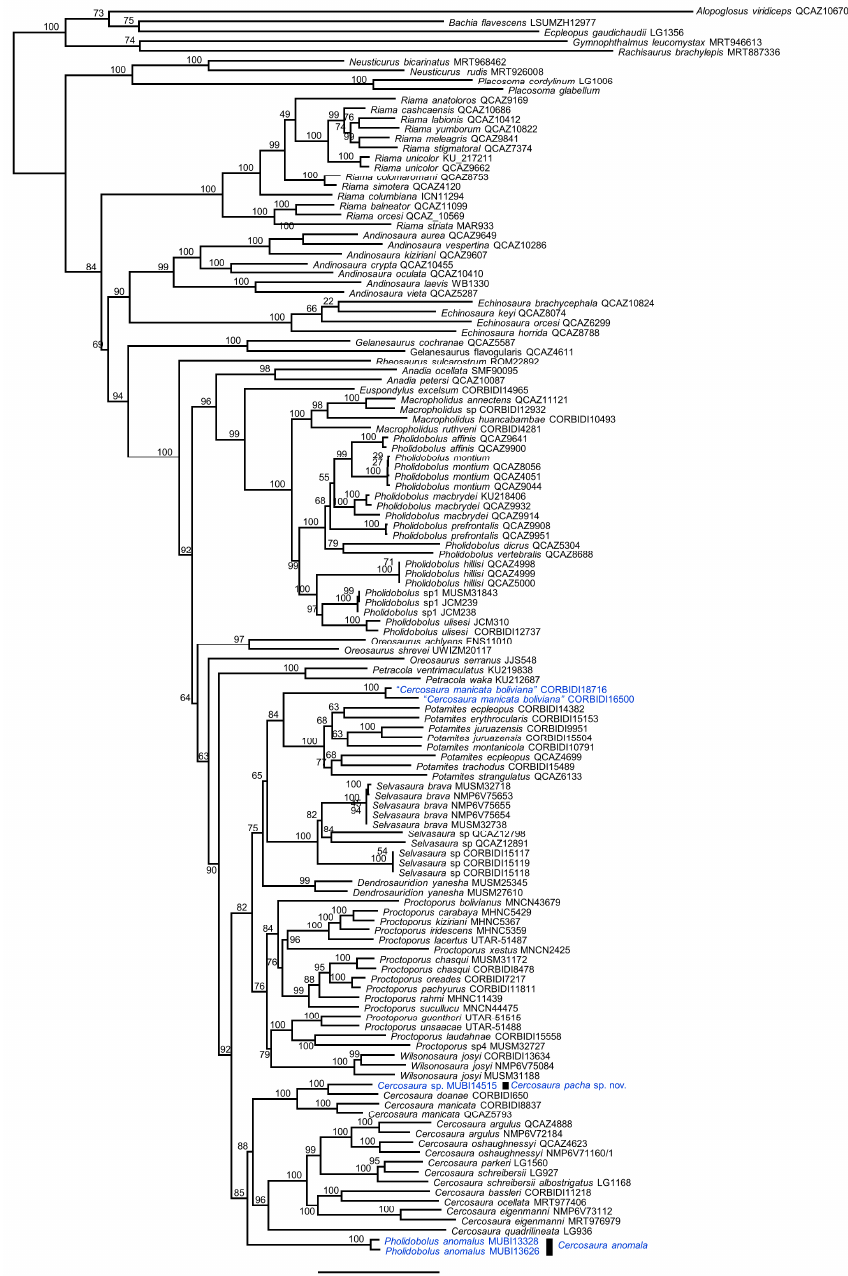
Figure 2. Maximum likelihood tree (log likelihood = − 44,674.306, ultrafast boostrap = 1000) showing the phylogenetic relationships of Cercosaura , Pholidobolus anomalus, and other gymnophthalmid lizards. The numbers next to the nodes are bootstrap values. The analysis was constructed from a concatenated dataset of 2167 bp of four mitochondrial genes (12S, 16S, Cytb, ND4) and a nuclear gene (c-mos). In blue are the samples obtained in this study.